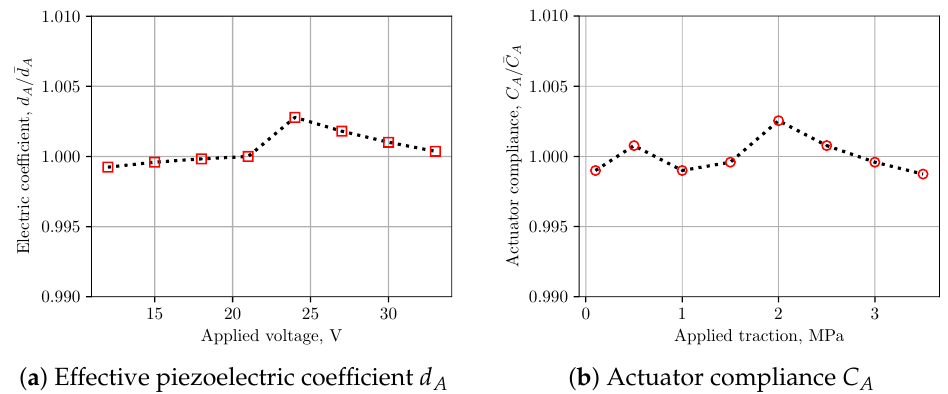
Figure 8. Variation of channel LEM parameters with applied traction and voltage. It is noted that piezoelectric coefficient and acoustic compliance are not very sensitive to applied loading conditions.